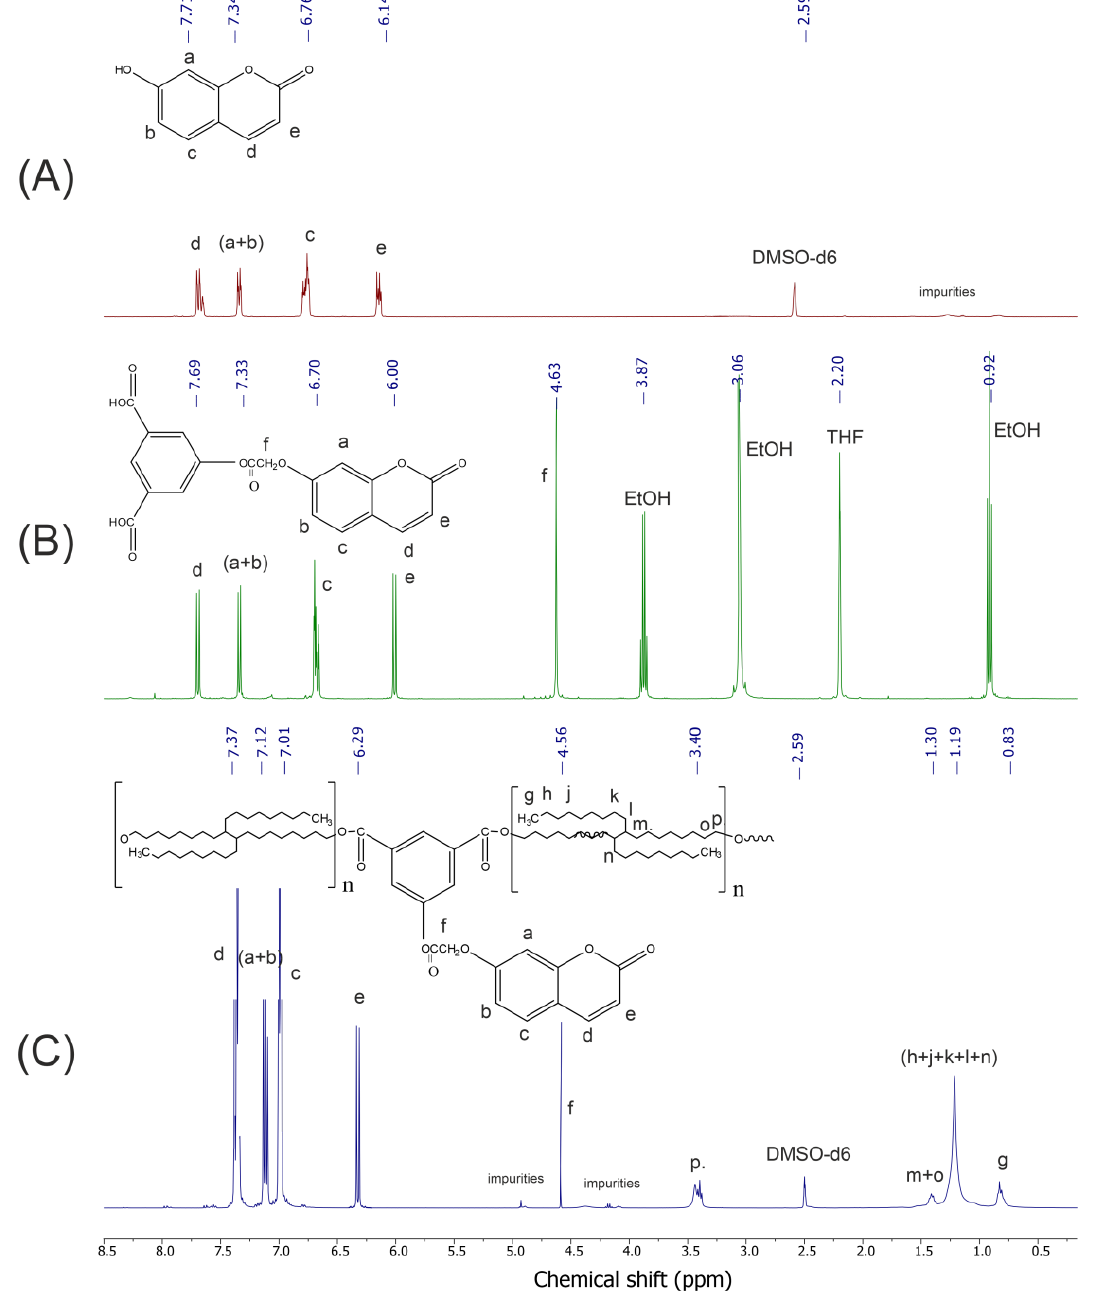
Figure 4. NMR spectra of 7−hydroxy−coumarin ( A ), ICM ( B ), and the final product the containing fatty acid dimer diol ( C ).